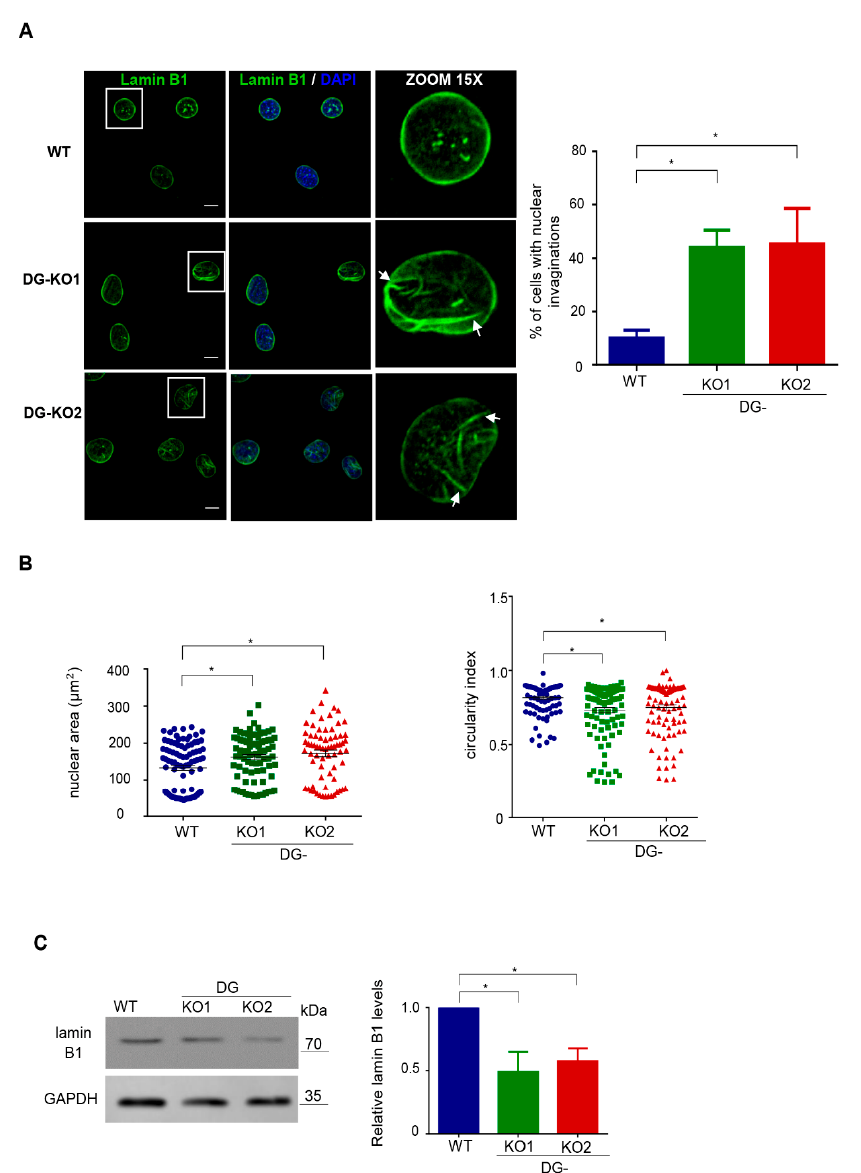
Figure 3 . DG-KO cells show altered localization and decreased protein levels of lamin B1. ( A ) WT, DG-KO1 and DG-KO2 cells, seeded on glass coverslips, were fixed and immunostained for lamin B1. Nuclei were stained with diamidino-2-phenylindole (DAPI) prior to confocal laser scanning microscopy analysis (CLSM), and typical images are shown. Bar, 10 µm. Right: the bar graph shows the percentage of nuclei with invaginations, with significant differences calculated in each cell culture from three independent experiments using one-way ANOVA and Dunnett´s post hoc test; data indicate the mean ± SEM ( n = 100 nuclei per cell culture; * p < 0.05 compared to WT). ( B ) Nuclear morphometric analysis was carried out on WT, DG-KO1 and DG-KO2 cells, as described in Methods from three separate experiments; significant di ff erences were obtained using a non-parametric Kruskal–Wallis test and post hoc Dunn´s method. Data correspond to the mean ± SEM ( n = 100 nuclei per experimental condition; * p < 0.05 compared to WT). ( C ) Lysates from WT and DG-KO1 and DG-KO2 cells were analyzed by SDS-PAGE / WB using antibodies against lamin B1 and GAPDH (loading control). Representative blots from three separate experiments are shown, with significant di ff erences obtained using one-way ANOVA and Dunnett´s post hoc test; * p < 0.05 in comparison to WT. Data indicate the mean ± SEM. Right: densitometric analysis of immunoblot autoradiograms was performed to estimate lamin B1 protein